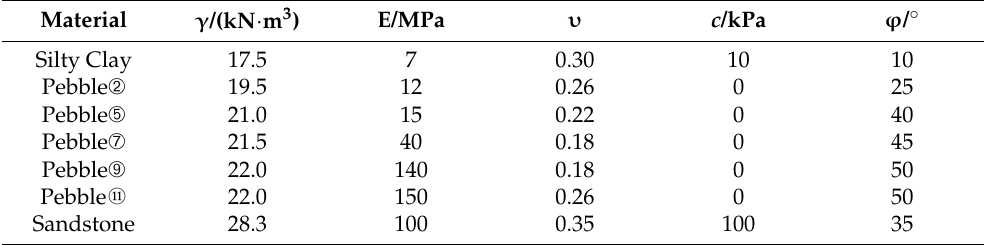
Figure 1. Location of open excavation foundation pit of Pingguo Yuan Station.